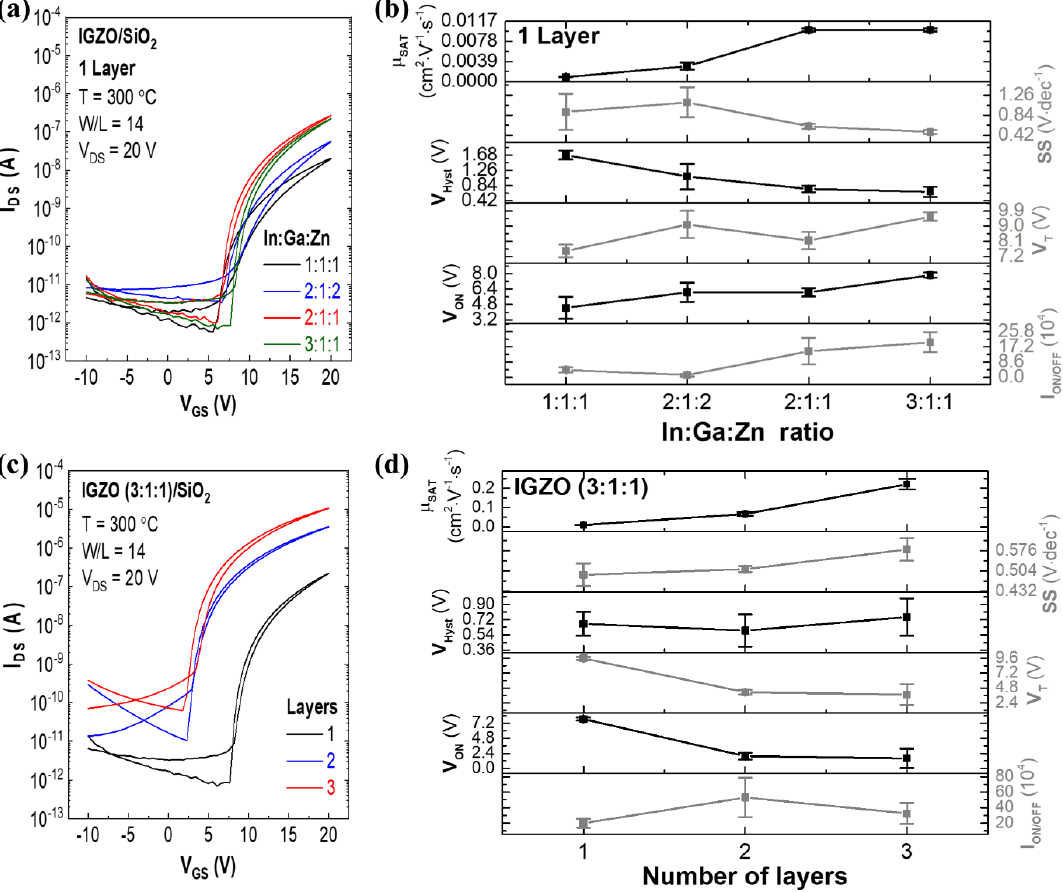
Figure 3. Transfer characteristics of IGZO thin-film transistors (TFTs) ( a ) with a different In:Ga:Zn ratio and ( b ) respective electrical parameters; ( c ) with 1-, 2- and 3-layer IGZO 3:1:1 TFTs and ( d ) their respective electrical parameters.